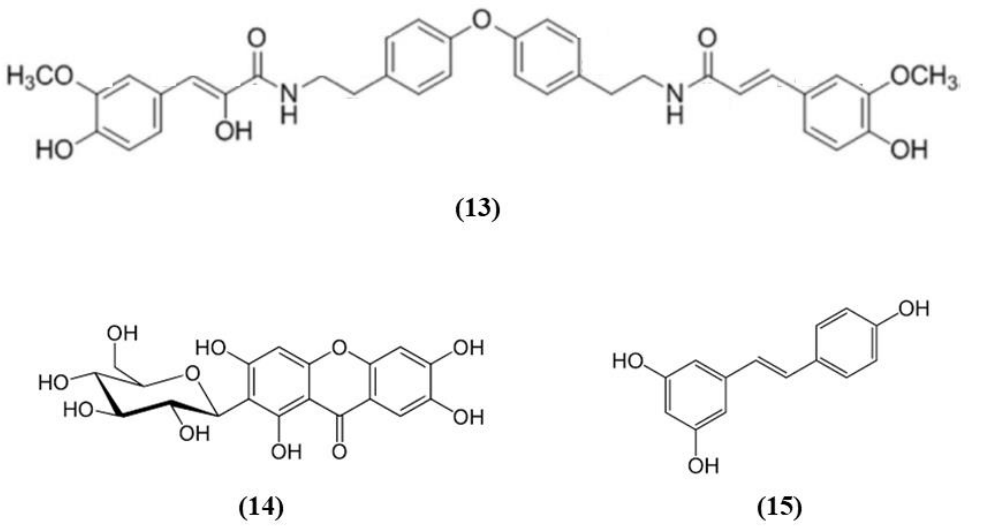
Figure 4. Chemical structure of ( 13 ) lyciumamide A, ( 14 ) mangiferin, and ( 15 ) resveratrol.